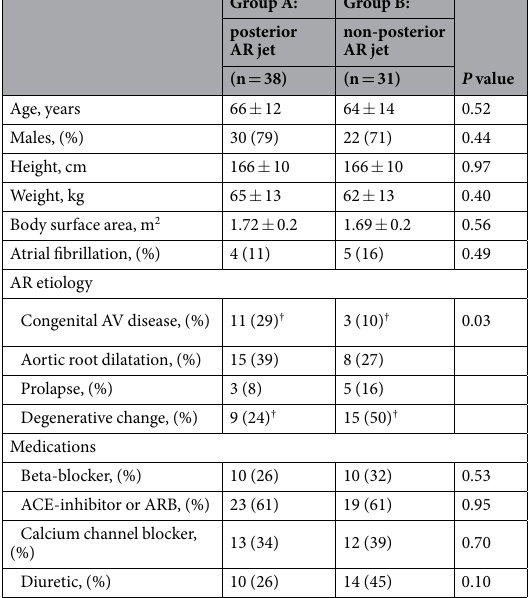
Table 1. Baseline characteristics. Values are mean ± SD or n (%). AR, aortic regurgitation; AV, aortic valve; ACE, angiotensin converting enzyme; ARB, angiotensin II receptor blocker. †Significant difference.